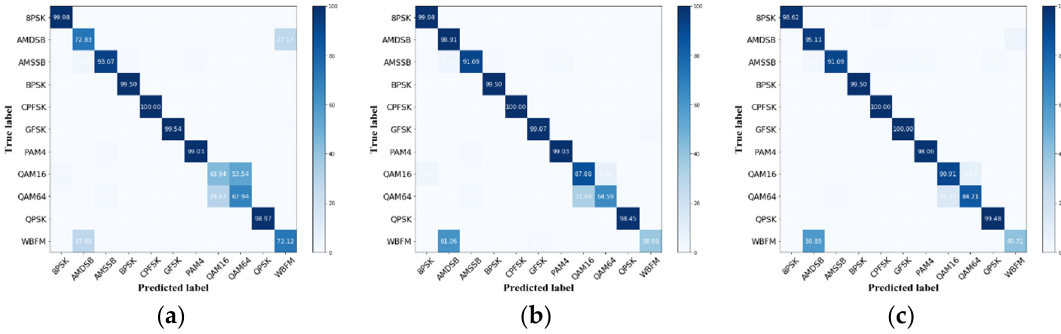
Figure 10. Confusion matrices of ( a ) CLDNN 100, ( b ) HMF-I, and ( c ) HMF on RadioML2016.10a (SNR = 12 dB).